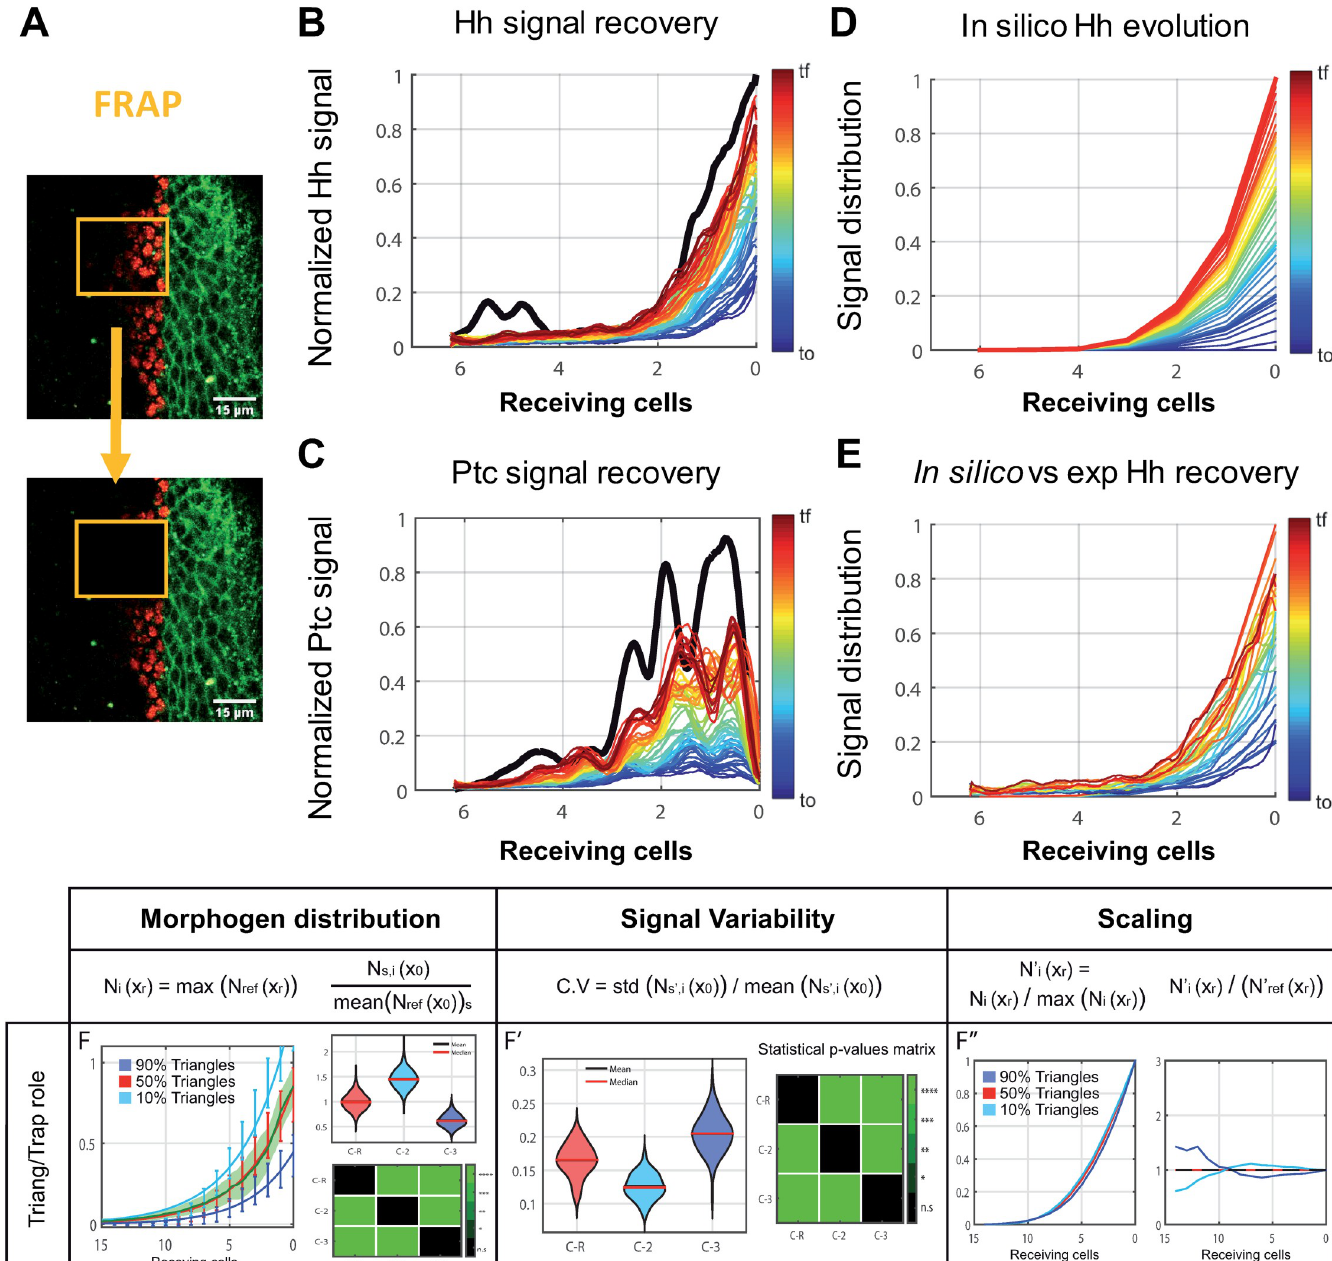
Fig 7. FRAP experiments to study the temporal gradient formation. (A) Representative image of FRAP experiments in abdominal histoblast nests in which the signal is eliminated after photobleaching over a specific ROI. (B) Hh ( Hh : GFP BAC ) gradient profile shortly before bleaching in black and Hh signal recovery over time coded in a hot colormap; each step corresponds to 45 seconds. (C) Ptc ( EnhancerPtcRed ) expression profile shortly before bleaching in black and ptc signal recovery over time coded in a hot colormap, each step is 45 seconds. D) In silico signal evolution predicted for abdominal histoblast nests. E) A graphical comparison every 3 minutes between in silico simulations and experimental data. F) Simulations for cytonemes contacting while growing with a different proportion of triangular/trapezoidal cytoneme dynamics (10% triangles in light blue, 50% triangles in red, 90% triangles in dark blue). Scale bars: 15 μ m.